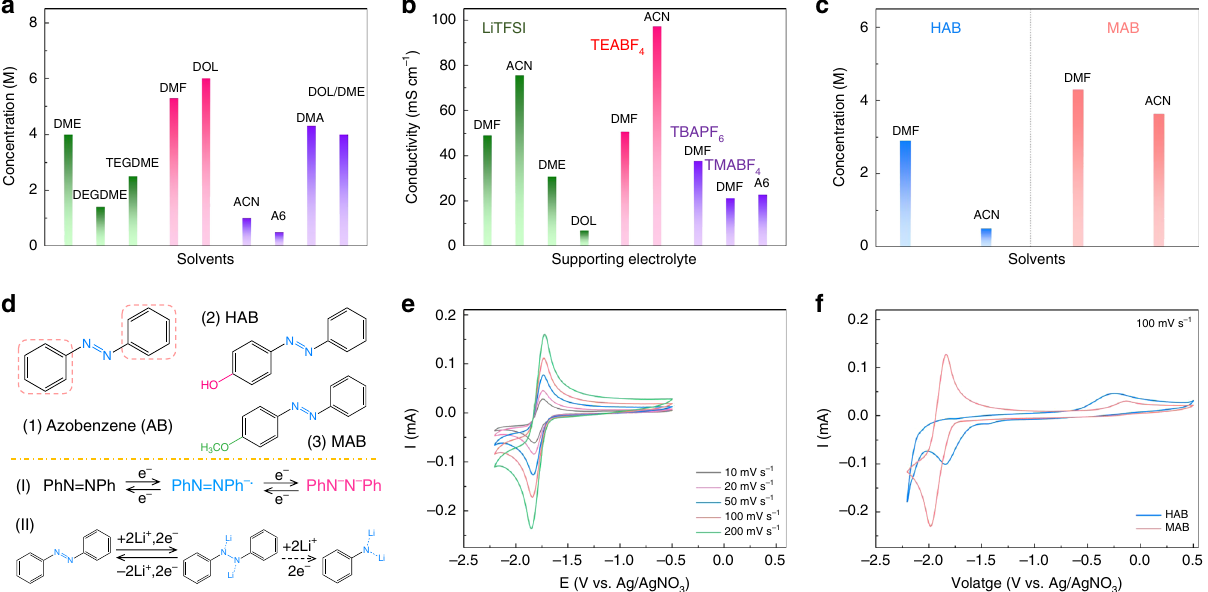
Fig. 1 Physical properties and redox chemistry of AB derivatives. a Solubility measurement of AB in various organic solvents. b Ionic conductivities of various supporting electrolytes at a concentration of 0.5 M. c Solubility of two AB derivatives in DMF or ACN solvents. d Molecular structure of AB and its derivatives and possible reaction mechanisms for AB. CV curves of AB ( e ) and its derivatives ( f ) at a concentration of 10 mM in 0.5 M LiTFSI DMF supporting